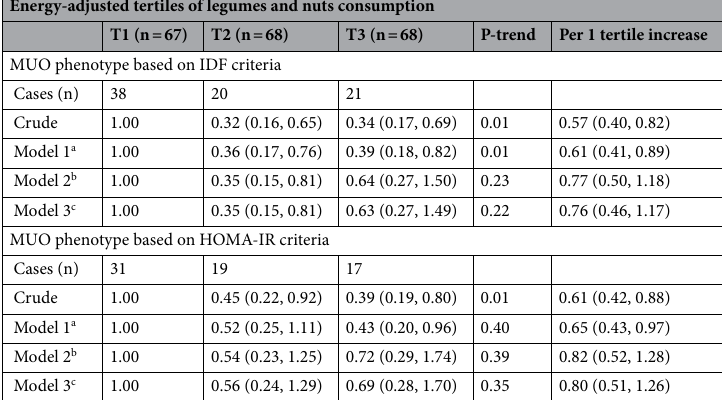
Table 3. Multivariate adjusted odds ratio (OR) and 95% confidence interval (CI) for MUO across energy- adjusted tertiles of legumes and nuts consumption 1 . All values are odds ratios and 95% confidence intervals. a Model 1: adjusted for age, sex, and energy intake. b Model 2: additionally adjustment for physical activity and socioeconomic status (parental education, parental job, number of family members, having car in the family, having computer/laptop, having personal room and having trip). c Model 3: additionally adjustment for body mass index (BMI).